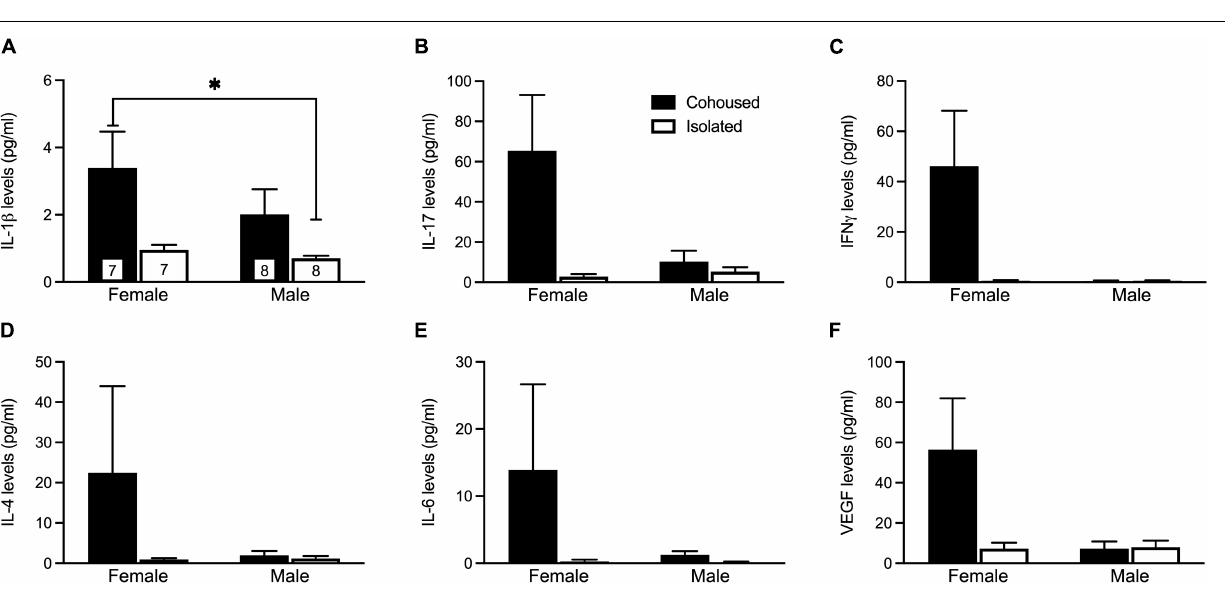
FIGURE 2 | Post-weaning alterations to IL-1 β plasma cytokine levels. Isolated males had significantly lower levels of IL-1 β (A) compared to cohoused females. Although not significant, similar patterns were seen for levels of IL-17 (B) , IFN γ (C) , IL-4 (D), IL-6 (E), and VEGF (F) . IL-17, Interleukin 17, IFN γ , interferon gamma, VEGF, vascular endothelial growth factor, IL-1 β , Interleukin 1 beta, IL-4, interleukin 4, IL-6, interleukin 6. Bars indicate mean ± SEM. The number within each bar on Panel A indicates the number of animals for each group. ∗ represents p <